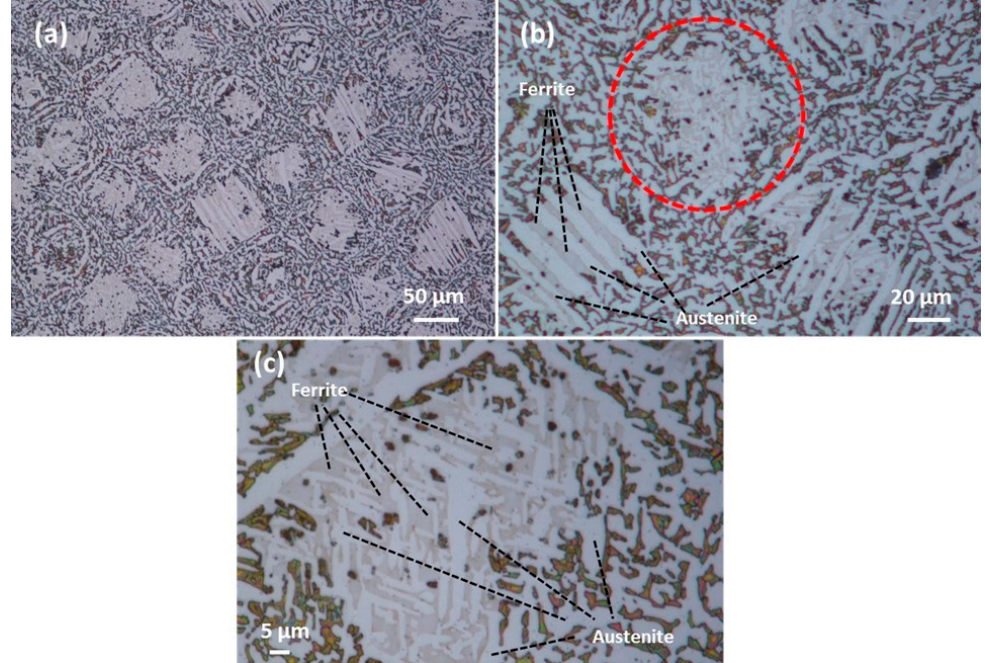
Figure 3. Optical imaging of the heat treated sample ( a ) mosaic texture containing austenite and ferrite grains ( b ) columnar austenite grains and ferrite grains in between austenite ( c ) higher magnification of the circled part in ( b ) showing Widmanstäten-like austenite grains and ferrite grains in between.